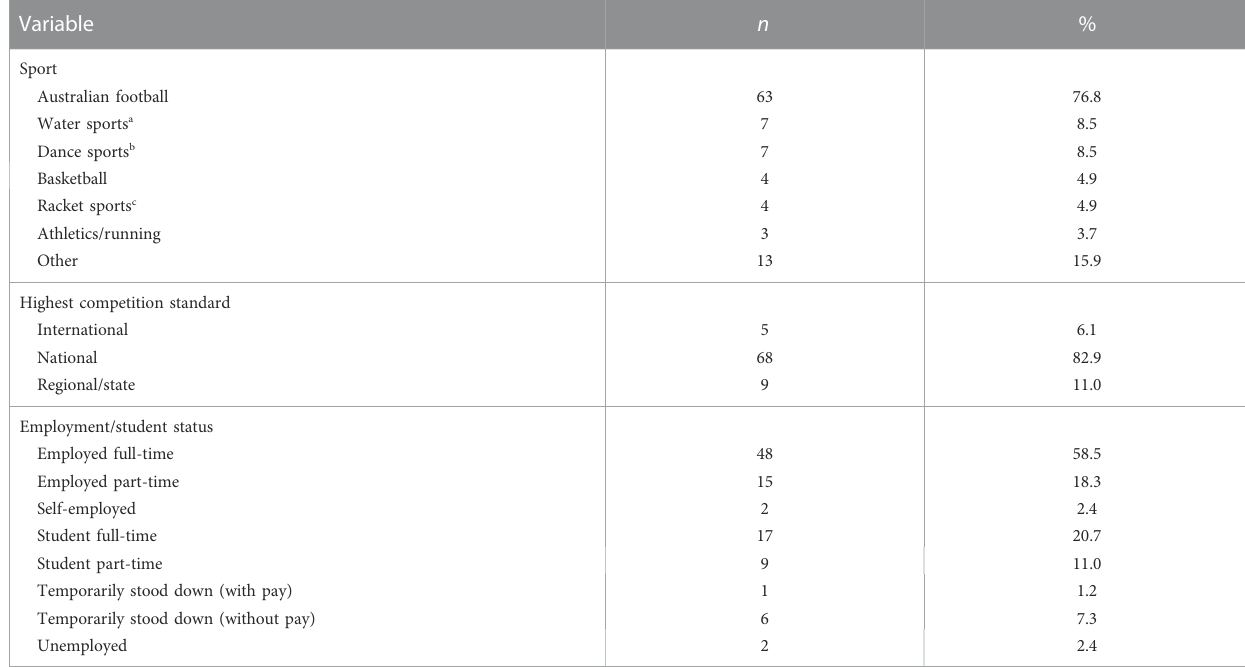
TABLE 2 Breakdown of sporting and employment